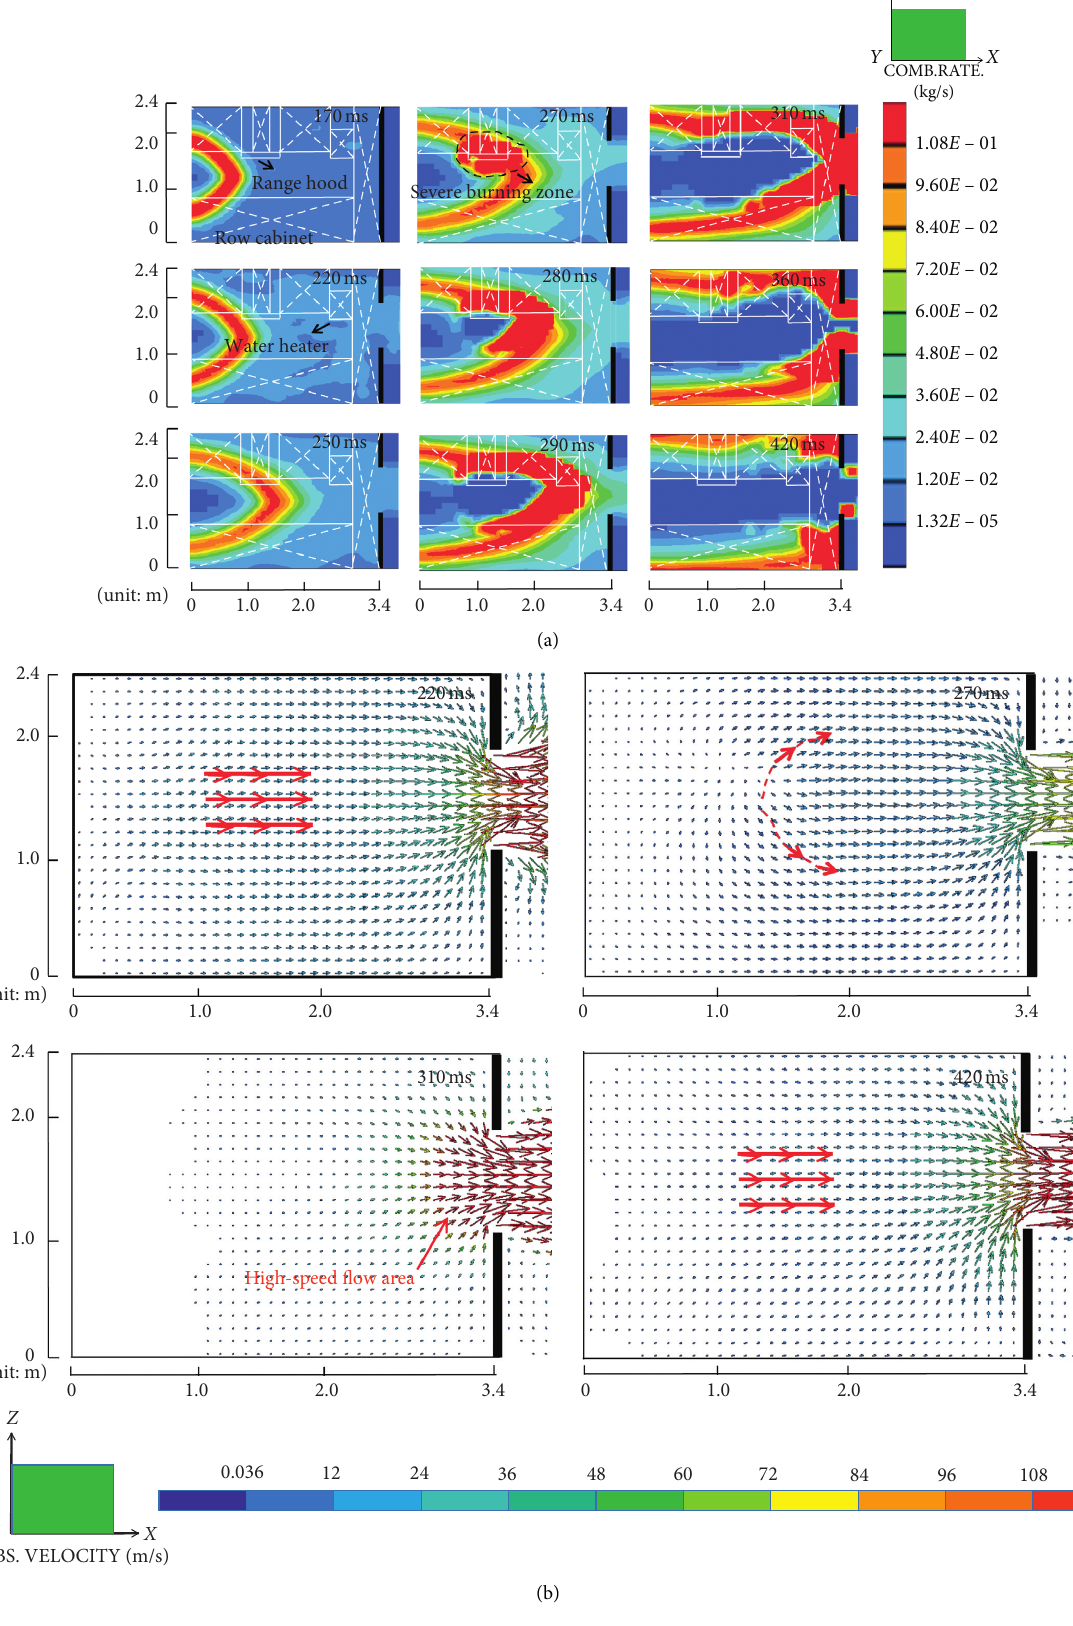
Figure 5: The change process of (a) flame propagation and (b) flow-field velocity vector on the y � 1.05m slice after